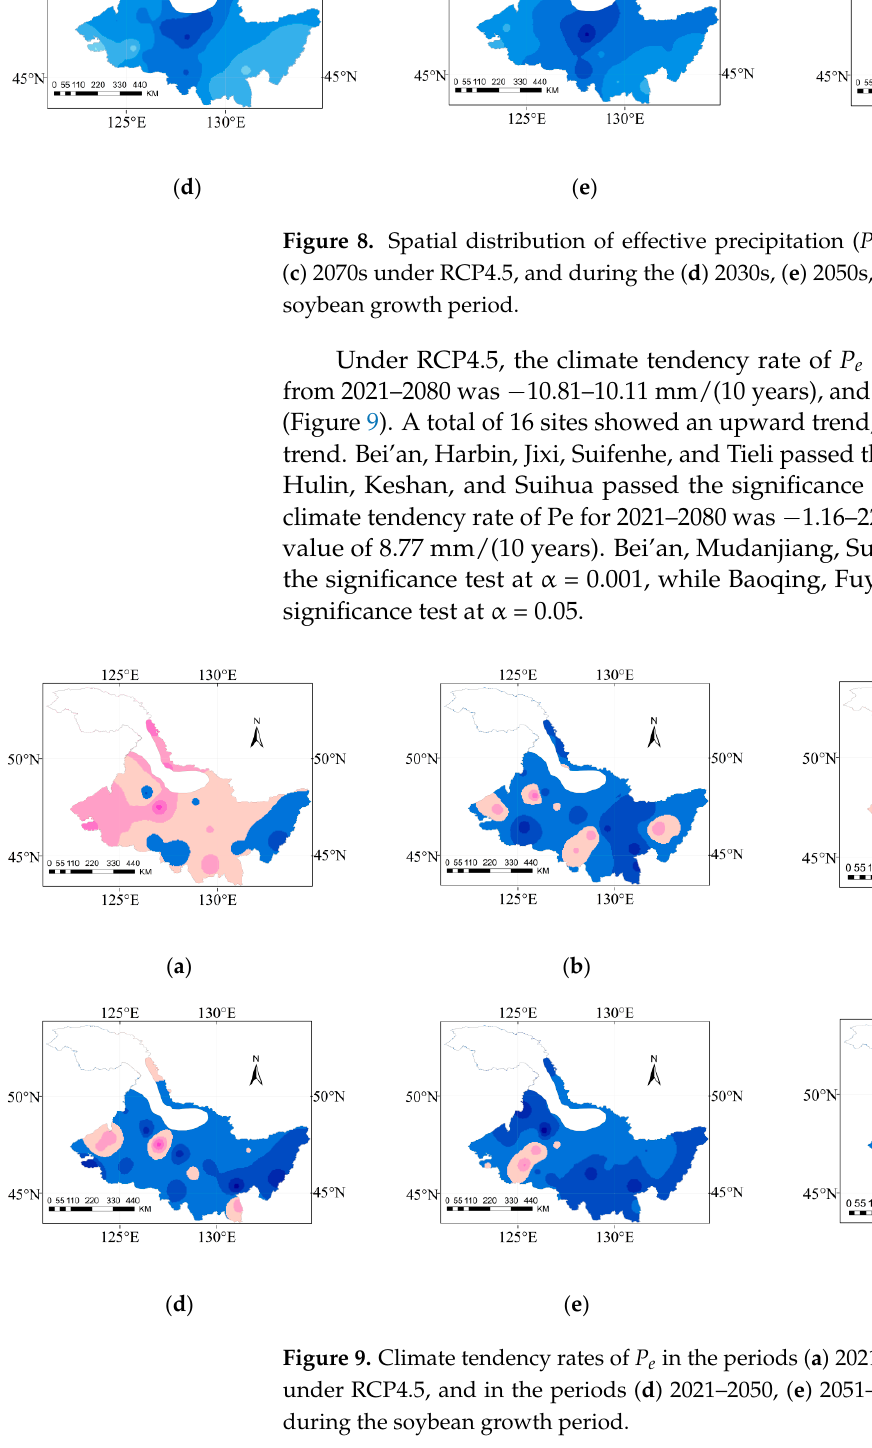
Figure 9. Climate tendency rates of P e in the periods ( a ) 2021–2050, ( b ) 2051–2080, and ( c ) 2021–2080 under RCP4.5, and in the periods ( d ) 2021–2050, ( e ) 2051–2080, and ( f ) 2021–2080 under RCP8.5 during the soybean growth